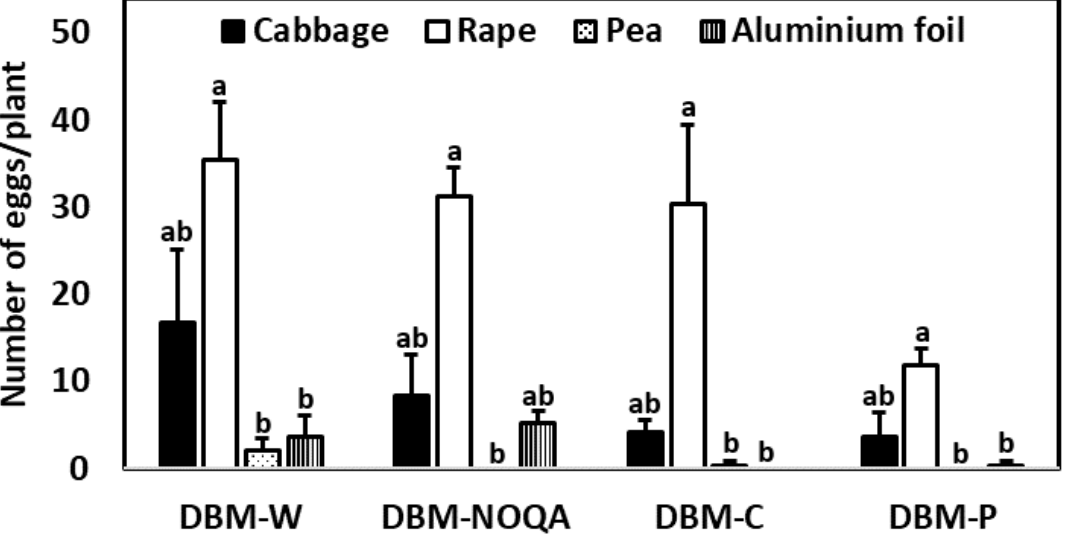
Figure 1. Mean ± SE eggs laid by P. xylostella strains DBM-W, DBM-NOQA, DBM-C, and DBM-P in a multi-choice setting consisting of cabbage, rape, pea, and aluminium foil. Significant differences ( p ≤ 0.05) in oviposition preference of each P. xylostella strain are shown with different lowercase letters.